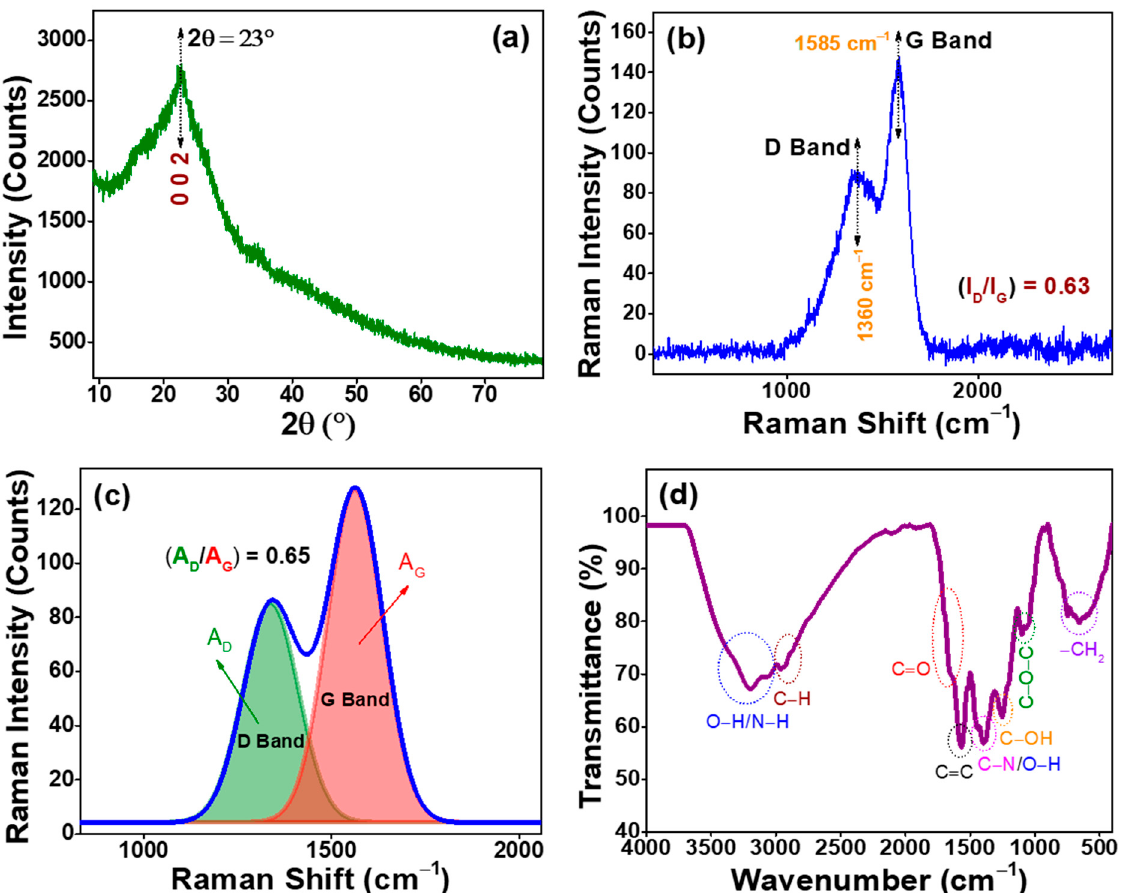
Figure 3. ( a ) Powder XRD pattern, ( b ) Raman spectrum, ( c ) deconvoluted Raman spectrum, and ( d ) ATR-FTIR spectrum of synthesized F-CNDs.